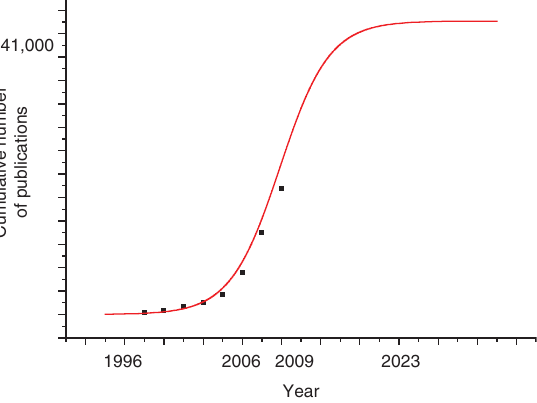
Figure 8 Use of the same system of axes for the two sigmoidal curves of Figures 2 and 7, in order to compare the time difference in their evolution. (The units on the vertical axis are total expenditures or total publications